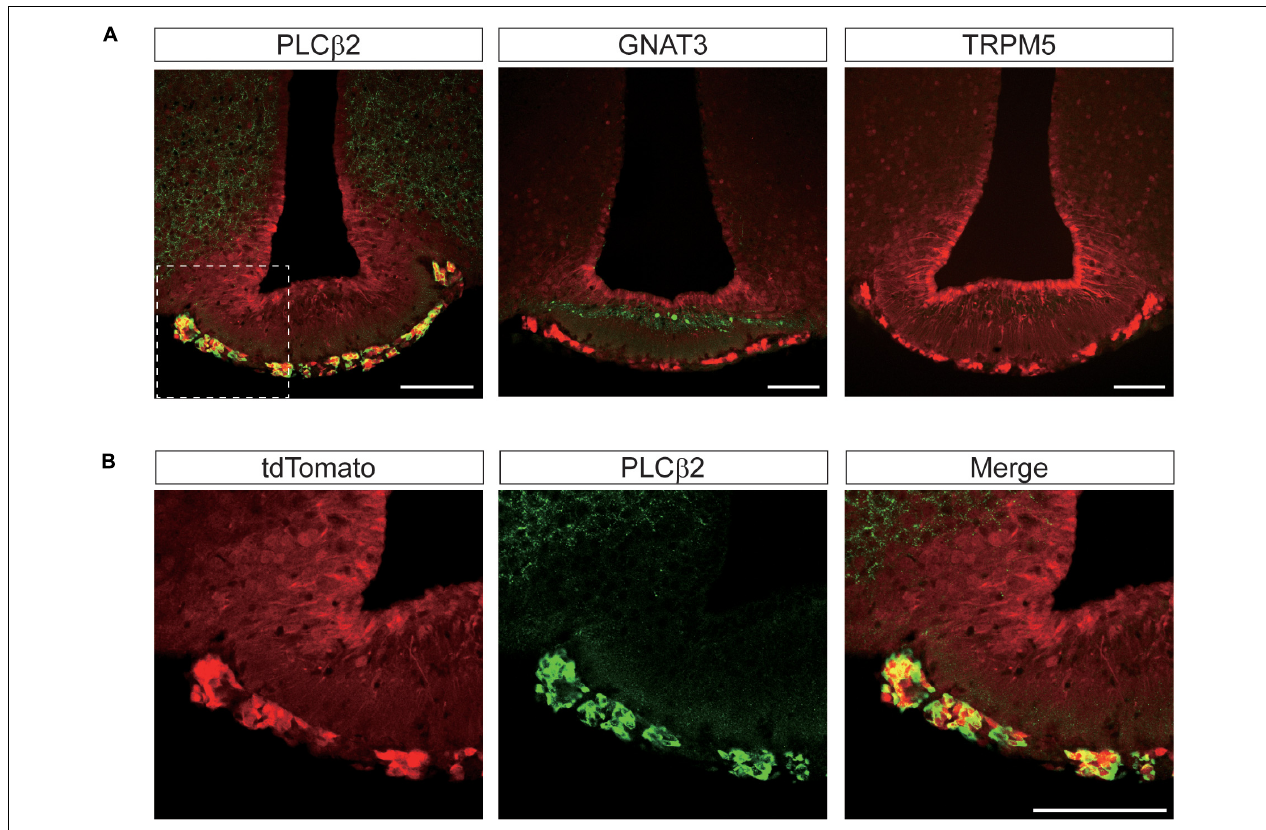
FIGURE 9 | Representative confocal images showing tdTomato fluorescence in the perivascular cells of the median eminence (ME) in T1r2 -tdTomato mice. (A) Double immunostaining of the ME for tdTomato and some canonical taste signaling molecules. Phospholipase C β 2 (PLC β 2), α -gustducin (GNAT3), and transient receptor potential M5 (TRPM5). (B) Magnified view of the white dotted box in Figure 8A . Representative markers are green; tdTomato appears in red. Scale bar, 100 µ